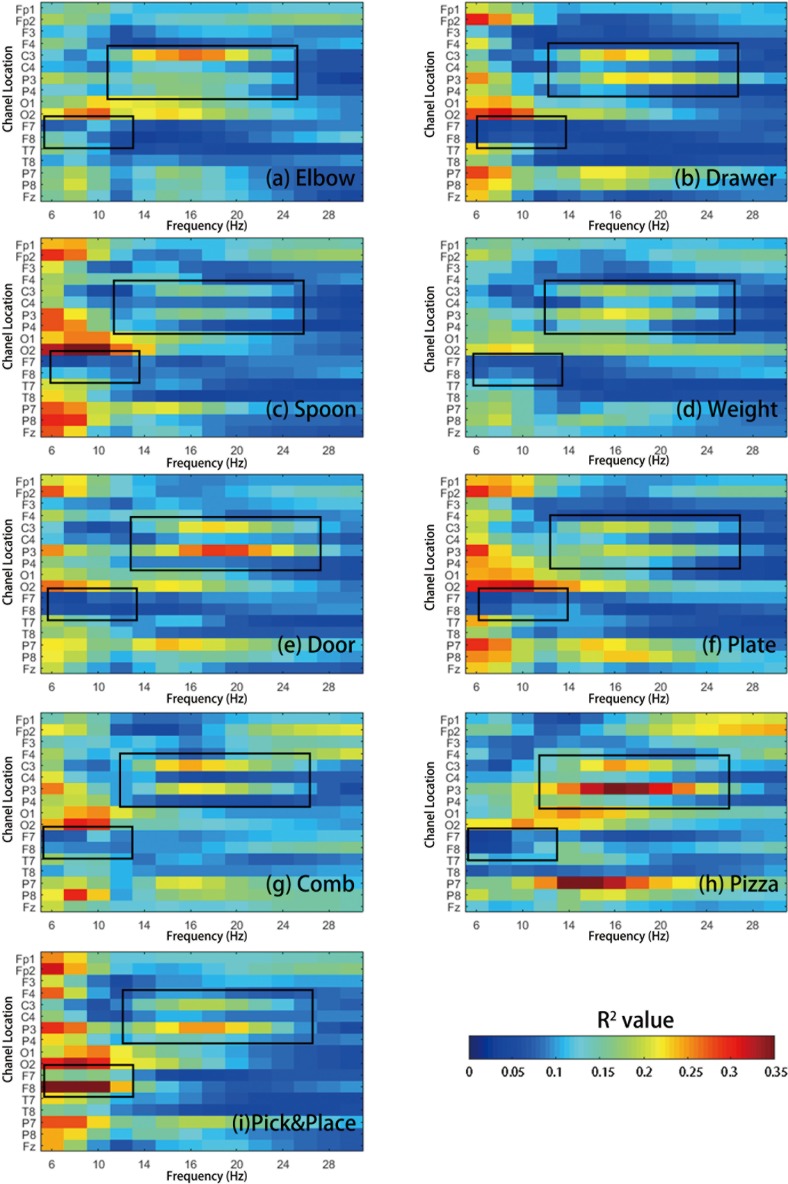
EEG R2 analysis for different motor imagery tasks, averaged among participants.(a) R2 value mapping for Rest Task vs Elbow Task; (b) R2 value mapping for Rest Task vs Drawer Task;(c) R2 value mapping for Rest Task vs Soup Task;(d) R2 value mapping for Rest Task vs Weight Task;(e) R2 value mapping for Rest Task vs Door Task(f) R2 value mapping for Rest Task vs Plate Task;(g) R2 value mapping for Rest Task vs Comb Task;(h) R2 value mapping for Rest Task vs Pizza Task;(i) R2 value mapping for Rest Task vs Pick&Place Task. Motor imagery related activities with high R2 value was labeled with a black box.